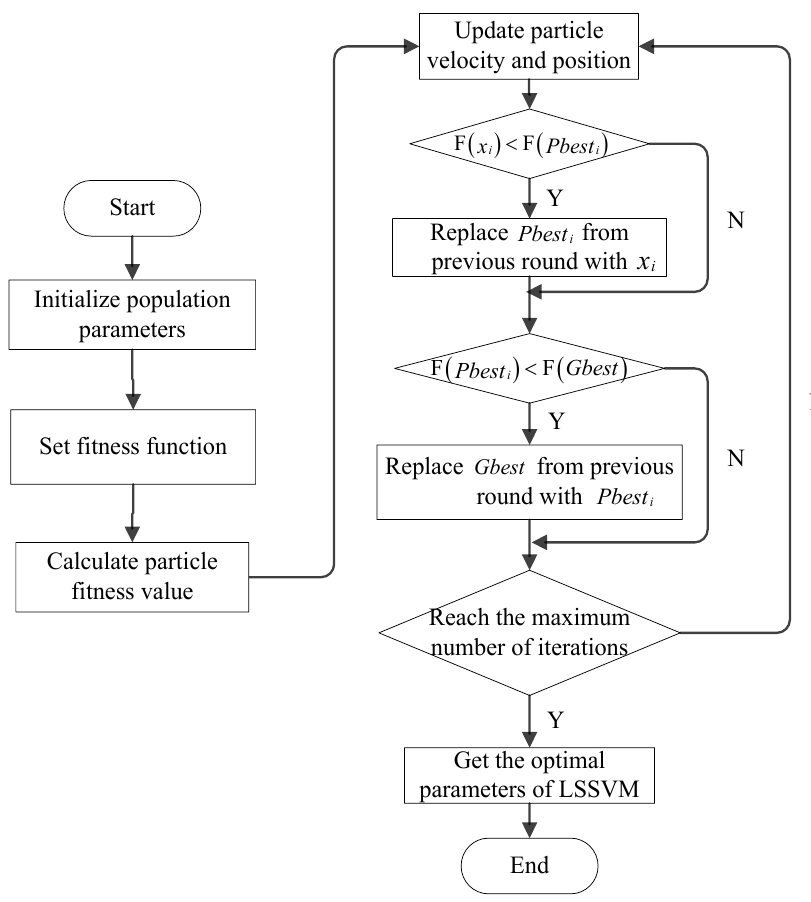
Figure 3. Flow chart of the PSO-LSSVM model.